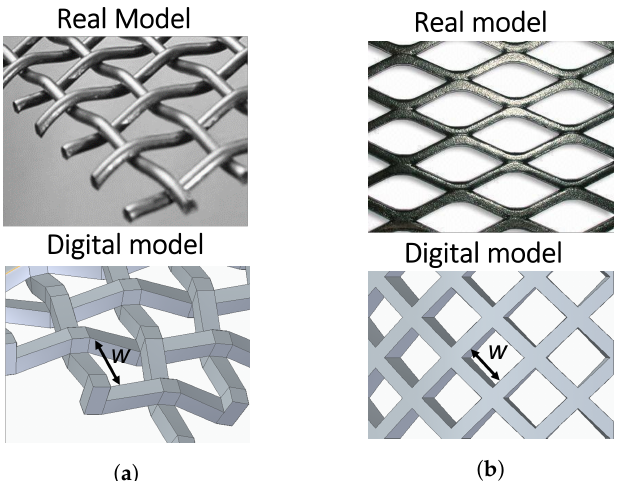
Figure 2. Real and digital model of ( a ) woven mesh electrode (WME), and ( b ) expanded mesh electrode (EME).